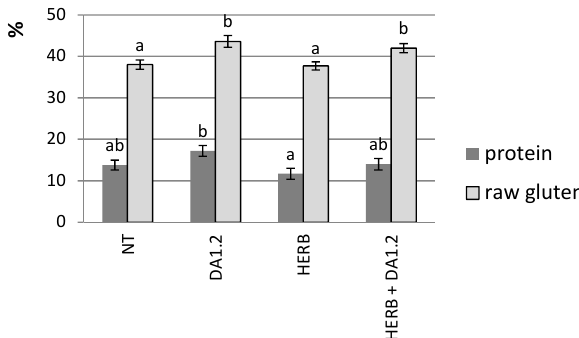
Figure 4. The percentage of protein ( n = 3) and raw gluten ( n = 6) in the average sample of grain harvested in 2020–2021. NT—no treatment was performed; DA1.2—treatment with Pseudomonas protegens DA1.2; HERB—herbicide treatment. Statistically different means are indicated by different letters ( p ≤ 0.05).